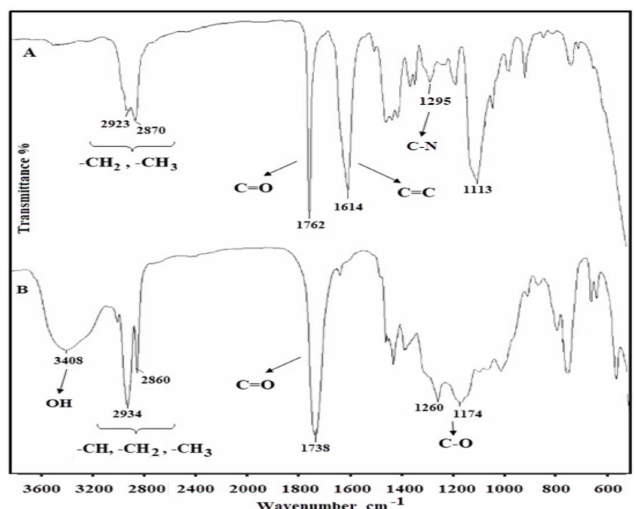
Figure 1. FTIR spectra of Kry23-DM cross-linker ( A ) and P (AA / Kry23-DM) SAP ( B ).